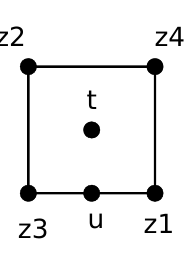
Figure 13 . Toric data for the toric dP 5 .